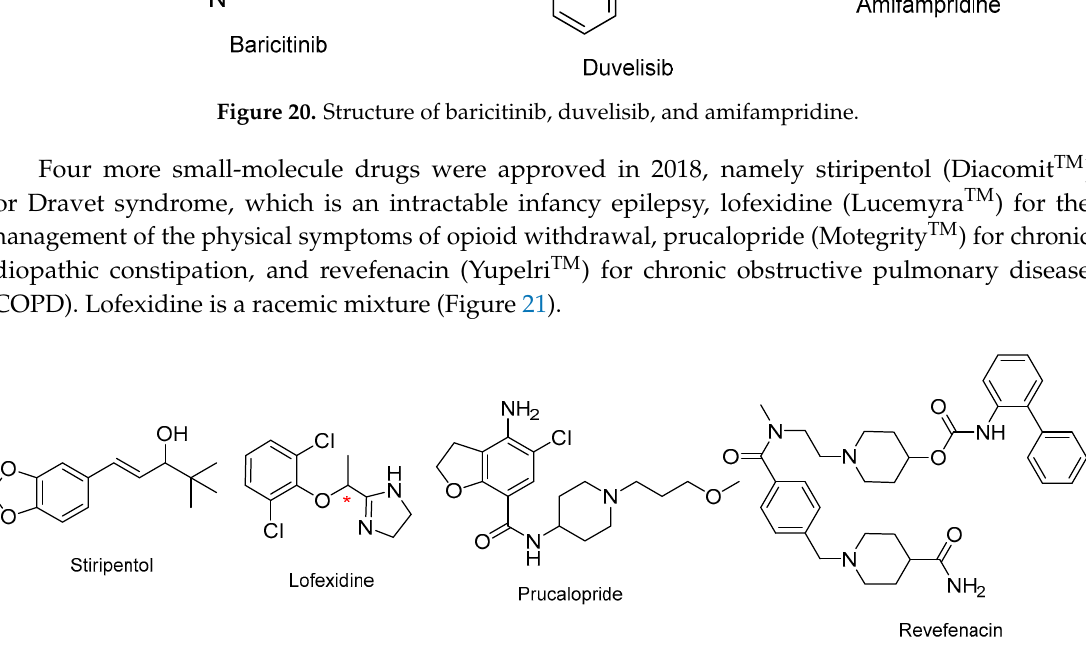
Figure 21. Structure of stiripentol, lofexidine, prucalopride, and revefenacin. (* denotes a chiral